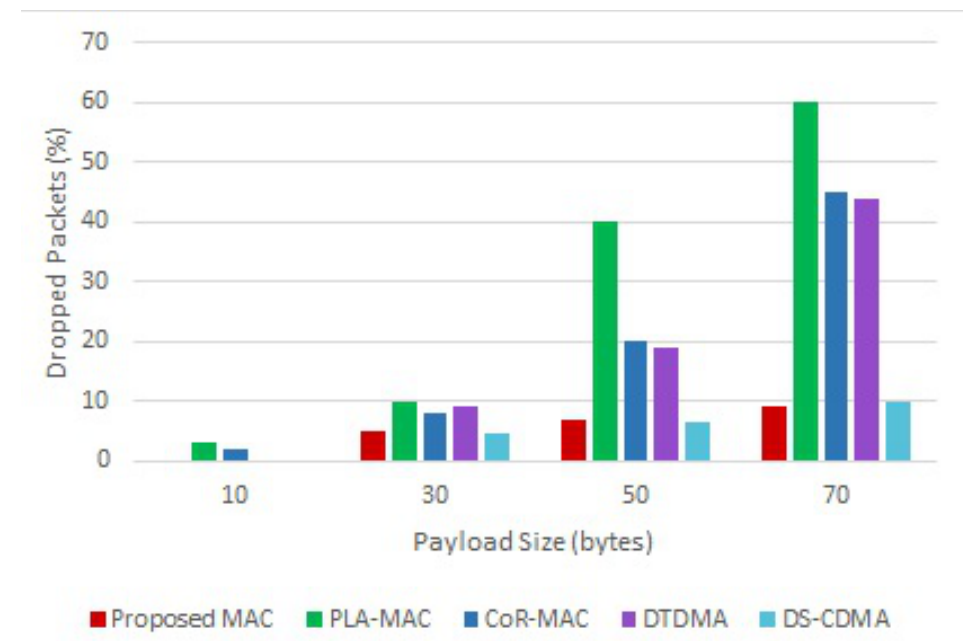
Figure 8. Packet Drop for Varying Payload